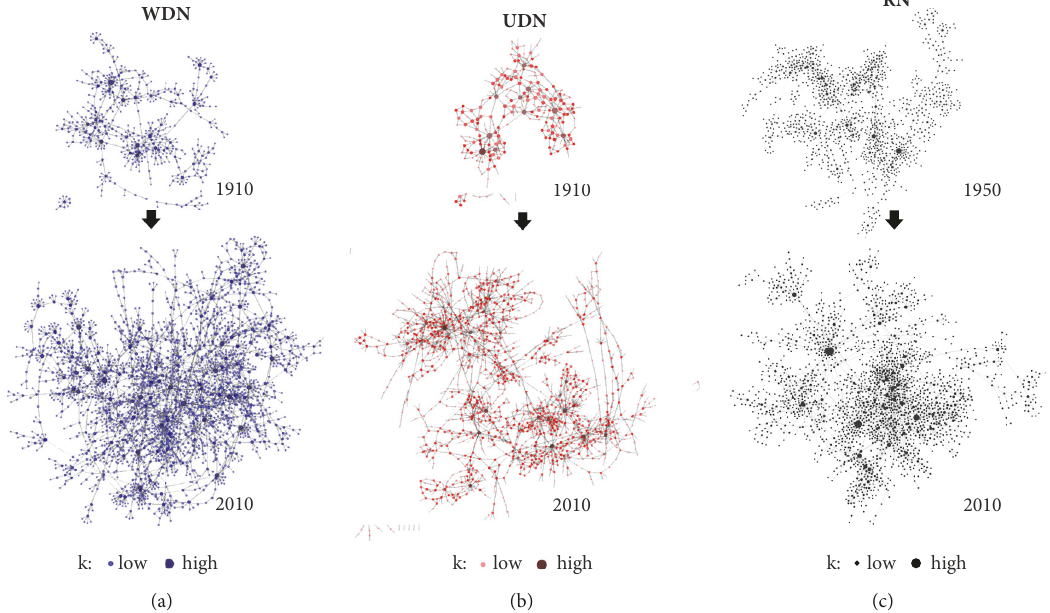
Figure 3: Dual mapped evolution of the infrastructure networks: (a) WDN, (b) UDN, and (c) RN. The color shading and size of the node indicates its degree. The network visualization was done using the program Cytoscape [29].